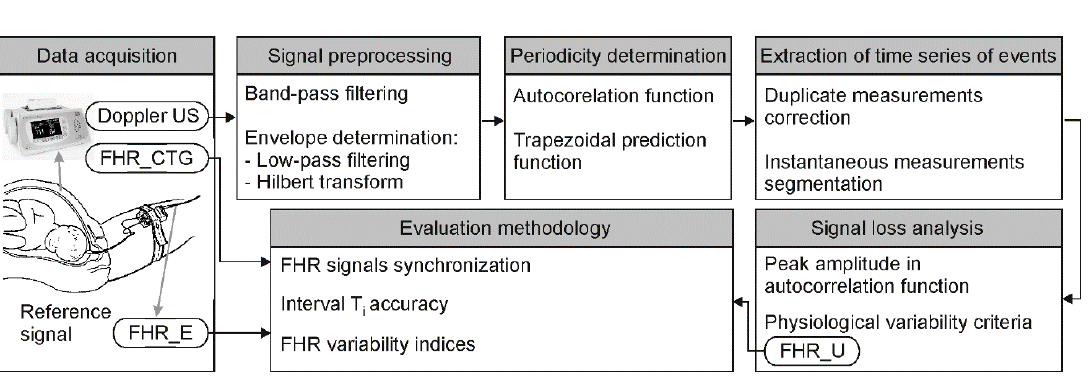
Figure 3. Block diagram generally describing the procedure of subsequent signal processing stages and methods for final evaluation of the results obtained.